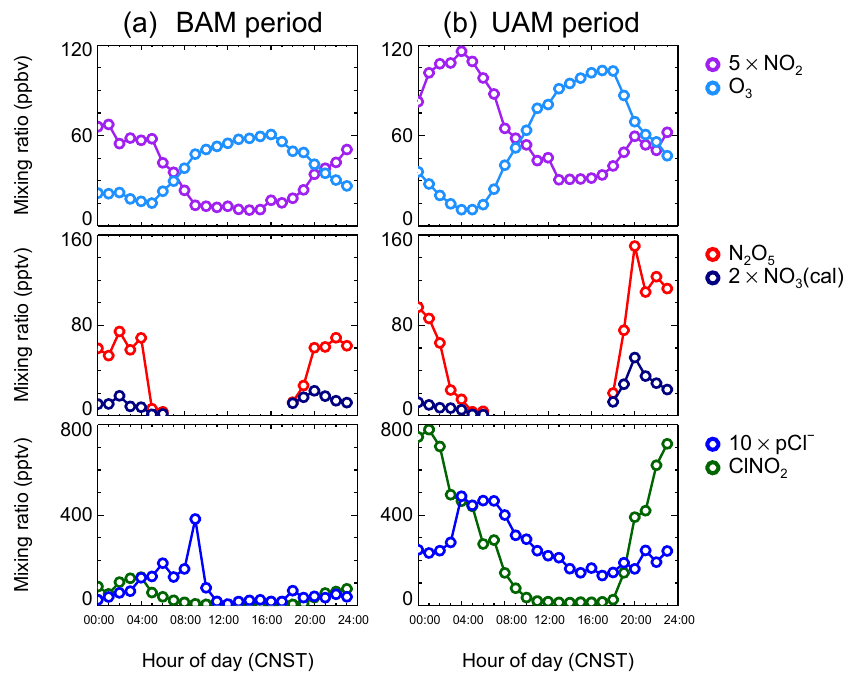
Figure 3. Mean diurnal profiles of 5 × NO 2 , O 3 , N 2 O 5 , 2 × NO 3 (calculated), ClNO 2 , and 10 × p Cl − . Panel (a) depicts the background air mass (BAM) period and (b) depicts the urban air mass (UAM)